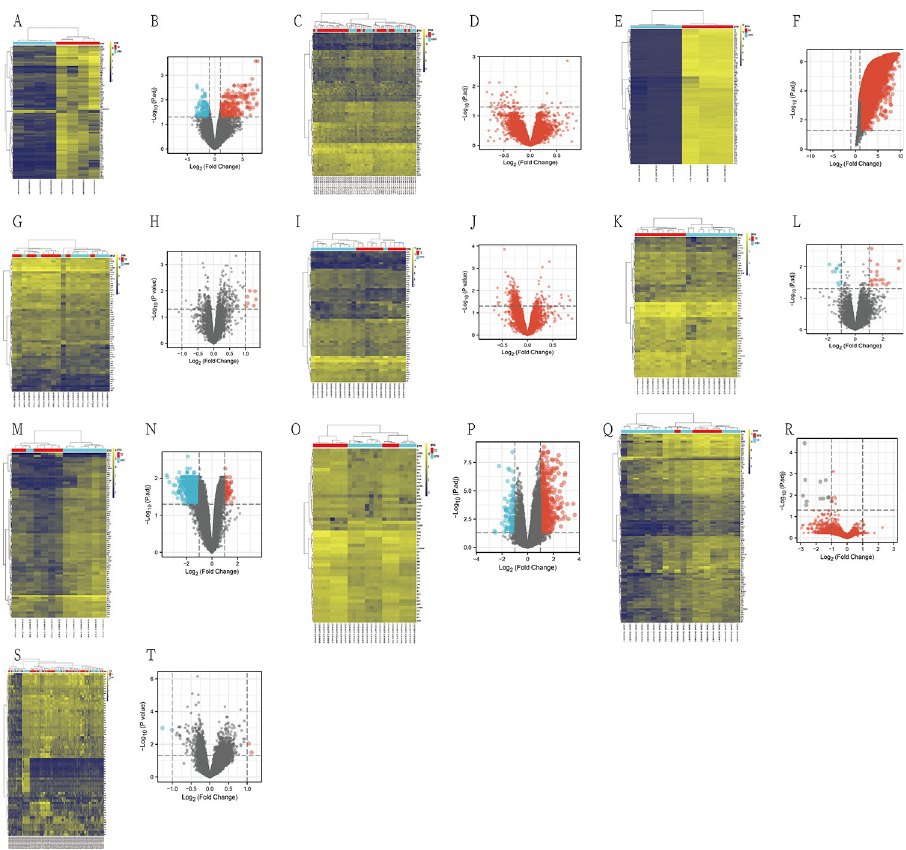
Fig 1. A.the heat map of GSE19339. B.the volcano map of GSE19339. C.the heat map of GSE48060. D.the volcano map of GSE48060. E.the heat map of GSE97320.F.the volcano map of GSE97320. G. the heat map of GSE12643. H.the volcano map of GSE12643. I.the heat map of GSE13760. J.the volcano map of GSE13760. K.the heat map of GSE20966. L.volcano map of GSE20966. M.the heat map of GSE25724. N.volcano map of GSE25724. O.the heat map of GSE29231. P. volcano map of GSE29231. Q.the heat map of GSE71416. R.volcano map of GSE71416. S.the heat map of GSE78721. T. volcano map of GSE78721.